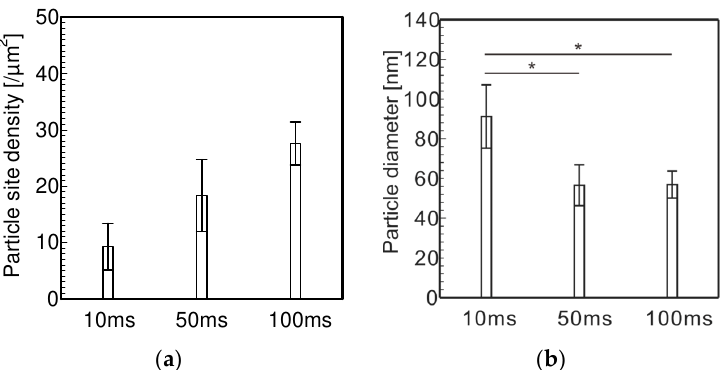
Figure 11. Measurement results of ( a ) particle site density (n = 27, mean ± S.D.) and ( b ) particle diameter (n = 45, mean ± S.D., * p < 0.05, Welch’s t test with Bonferroni correction) of P-Ni-CF plated using different ON-times ( I = 200 mA, J = 3.79 A/m 2 , t OFF = 100 ms, t = 5 s).